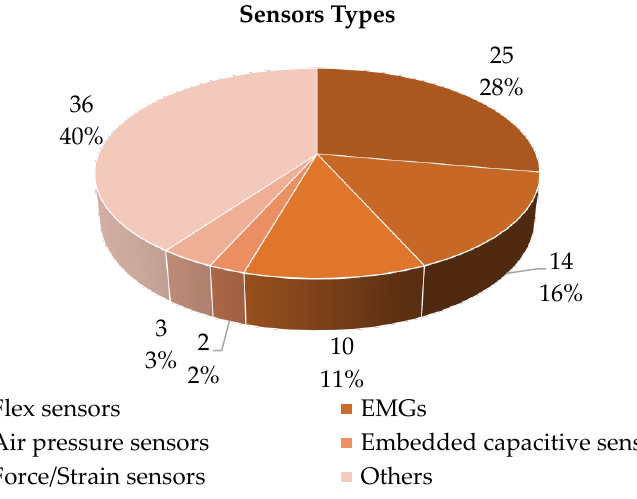
Figure 24. Sensors types used in the soft gloves analyzed in the review. Different applications of haptic soft gloves are possible, as to give sensory feedback to amputee when using hand prostheses or for virtual reality applications, for which hand pose detection and/or tactile feedbacks are